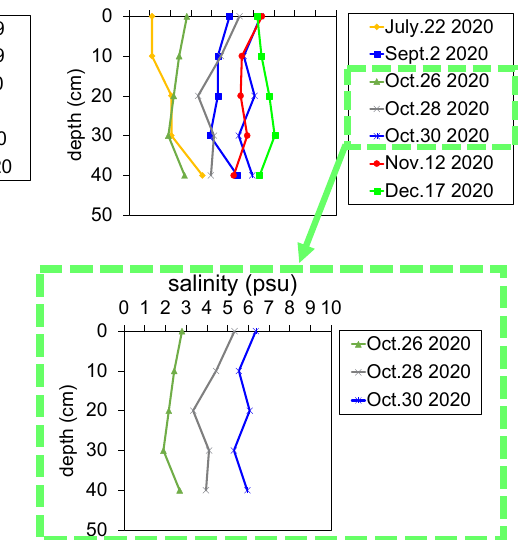
Figure 8. Vertical profile of soil salinity.